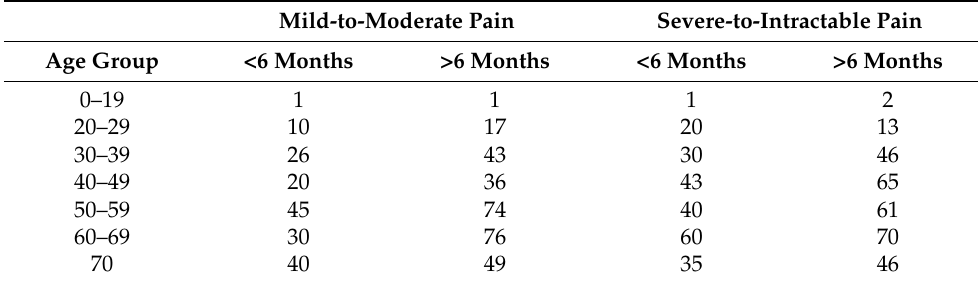
Table 2. Distribution of patients according to severity of pain, age, and duration of symptoms.